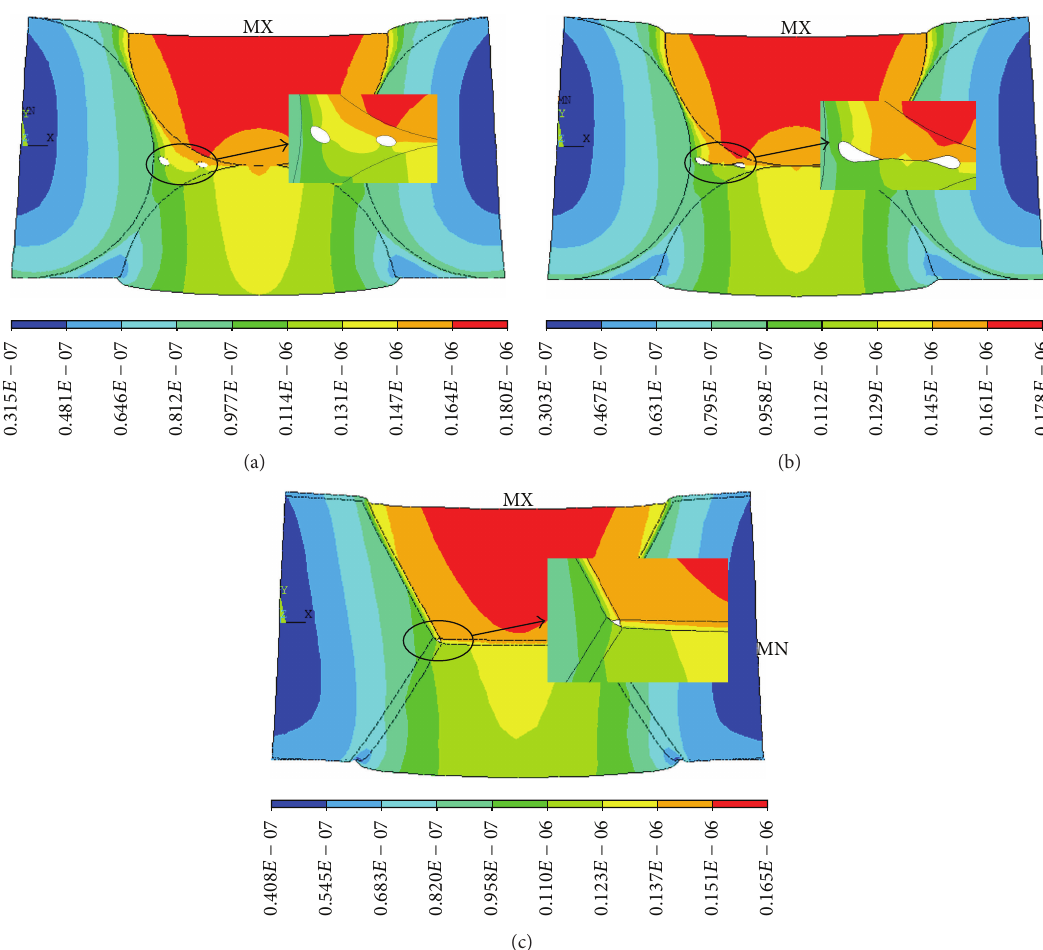
Figure 14: Displacement vector sum for three models: (a) circular pores; (b) circular pores with acute angle; (c) hexagon pores with acute